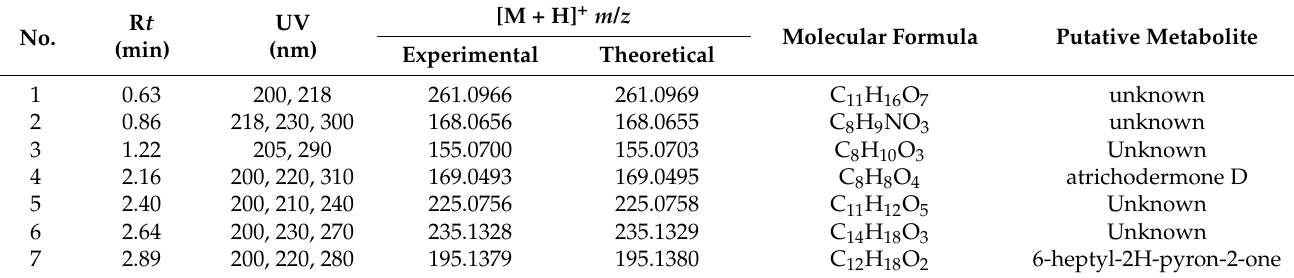
Table 4. Dereplication metabolites from ethyl acetate fraction of Trichoderma ghanense Th26-52. Putative Metabolite No. Formula Experimental Theoretical